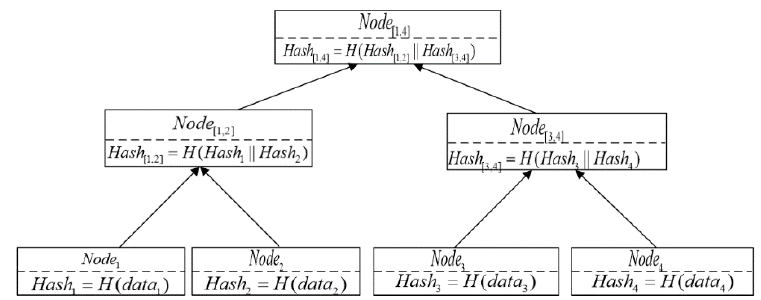
Figure 5. Merkle Tree for traceability information.